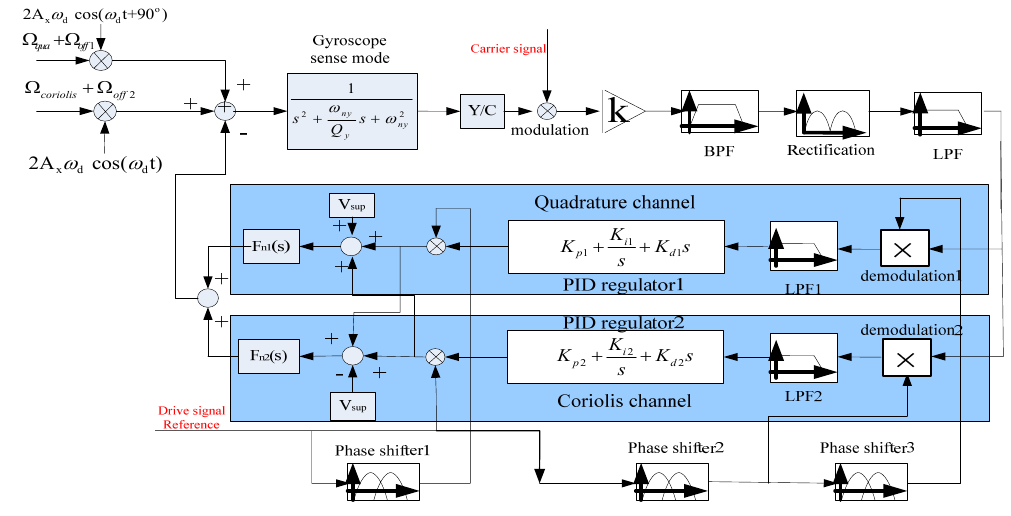
Figure 5. Sense mode circuitry